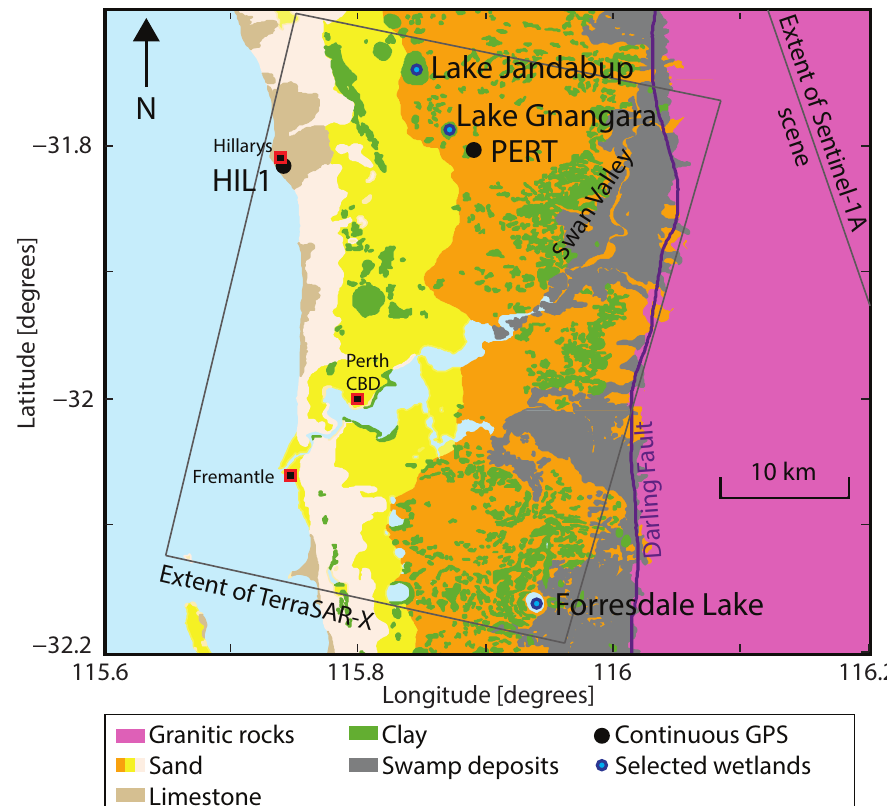
Figure 2. Simplified surface geological map of the study region adapted from Davidson [43] showing the coverage of InSAR data frames used in this study. The extent of the TerraSAR-X scene is shown by the grey box. The Sentinel-1A scene covers the whole region up to the labelled grey line. Labelled wetlands are those described throughout this study. The Darling Fault, shown by the purple line, marks the eastern margin of the Perth Basin. Red/black squares indicate locations within the metropolitan area described in the text: Hillarys, Fremantle and Perth central business district